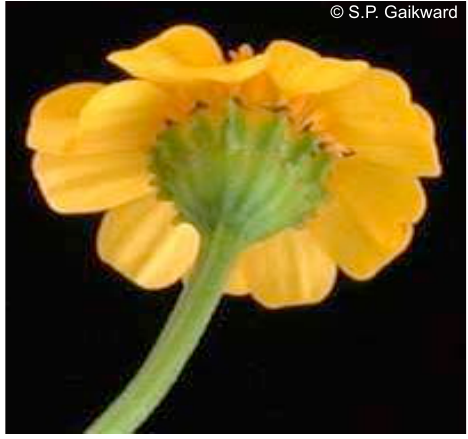
Note: Peculiar yellow oil glands are present on the outer side of involucral